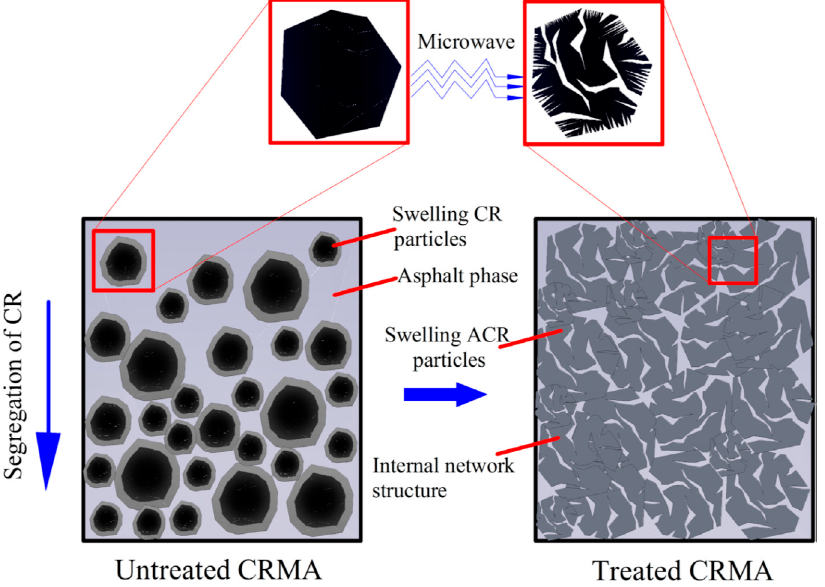
Figure 10. Proposed mechanism while incorporating microwaves ‐ treated or untreated rubber [61].